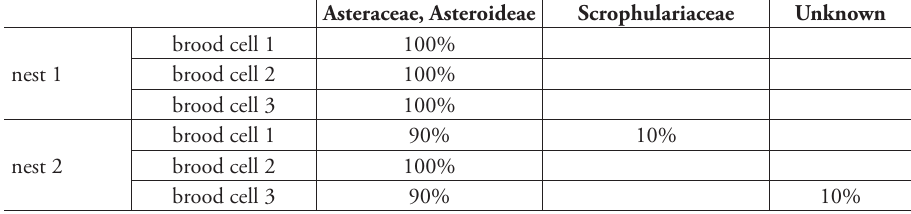
Table 1. Pollen composition of larval faeces of Wainia sexsignata in two nests with three brood cells each. Asteraceae, Asteroideae